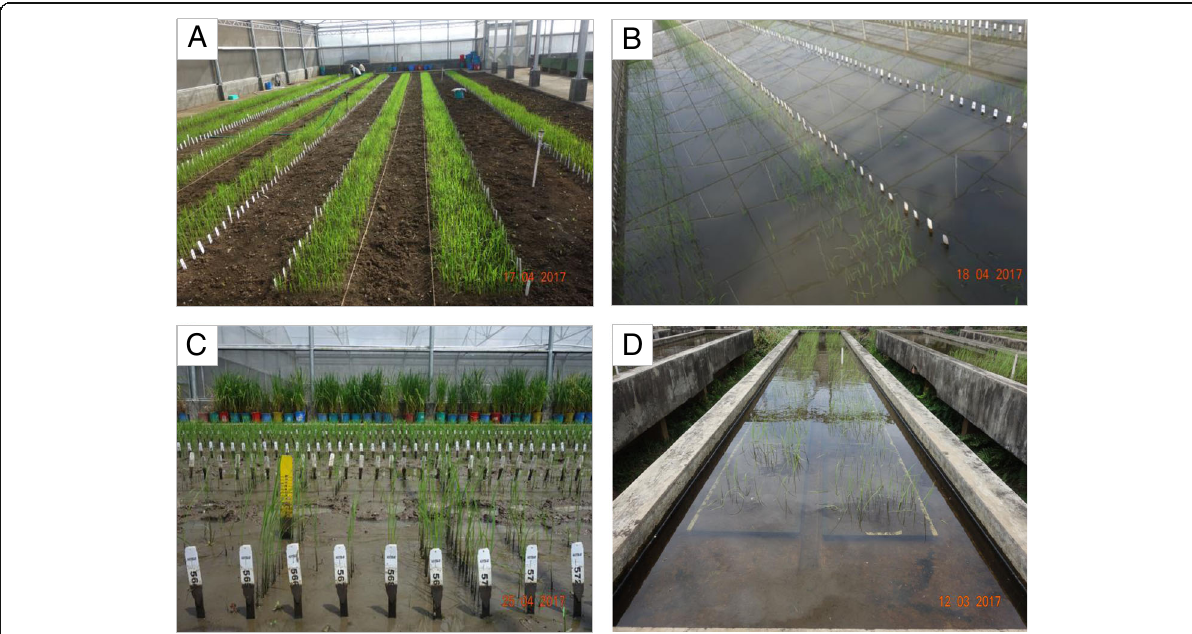
Fig. 1 Phenotyping of the rice mapping population (BC 1 F 2:3 ) in screenhouse. a Control experiment at 14 DAS, b stress experiment at 14 DAS, c stress experiment at 21 DAS after removing water in the screenhouse, and d stress experiment at 14 DAS in